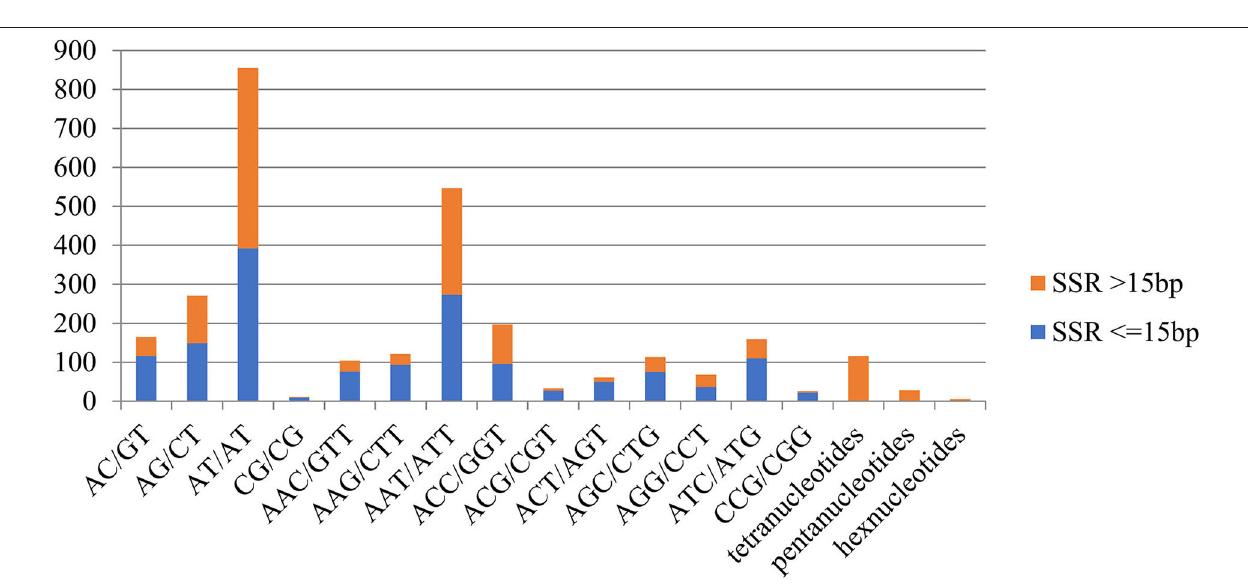
Frontiers in Sustainable Food Systems |